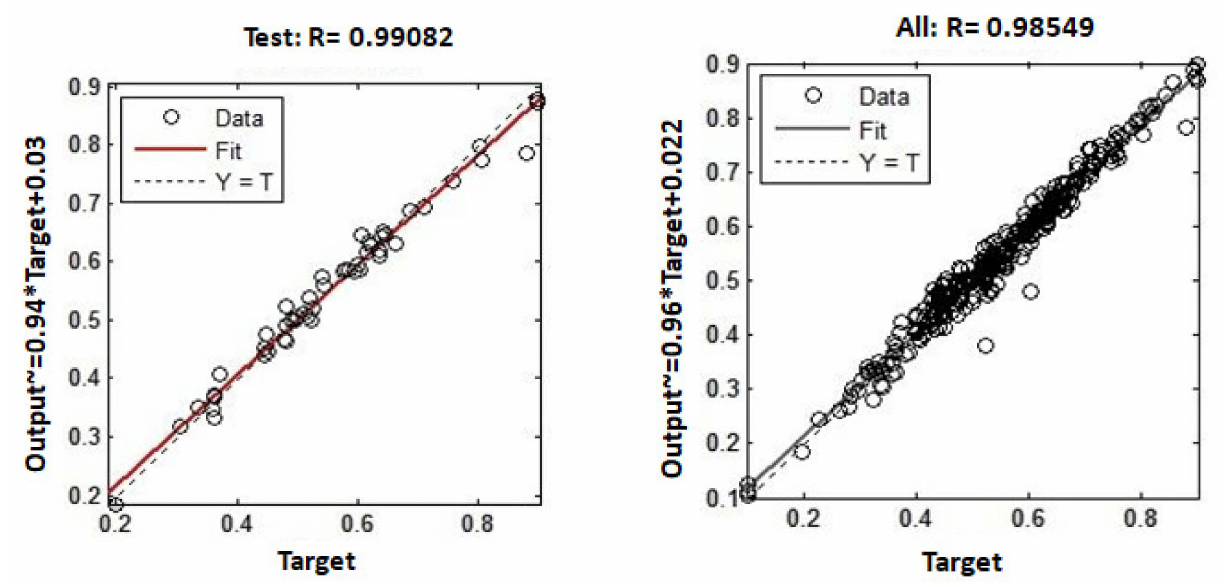
Figure 13. Regression graph for angular distortion with time gap between two, three and four passes pertaining to network 4-4-3.